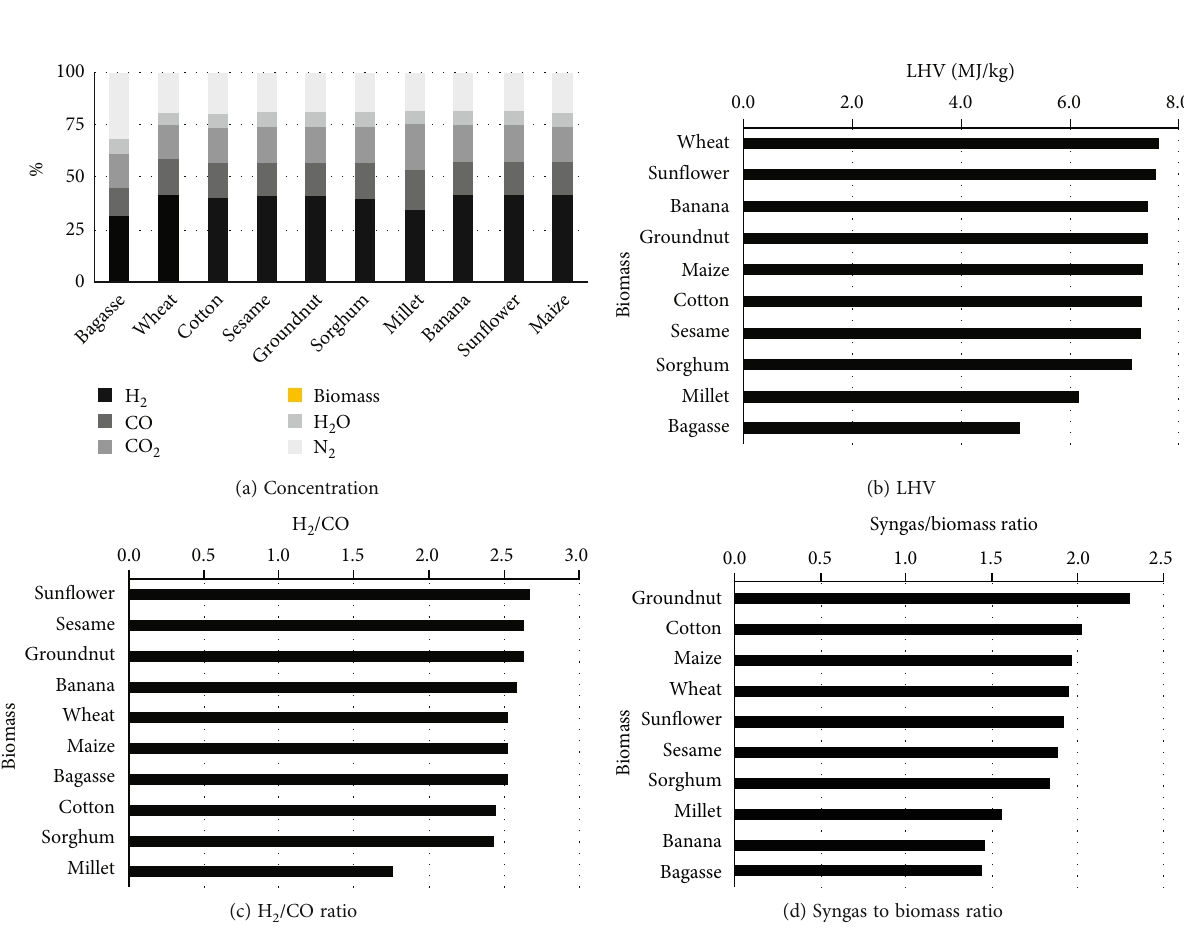
Figure 6: Syngas